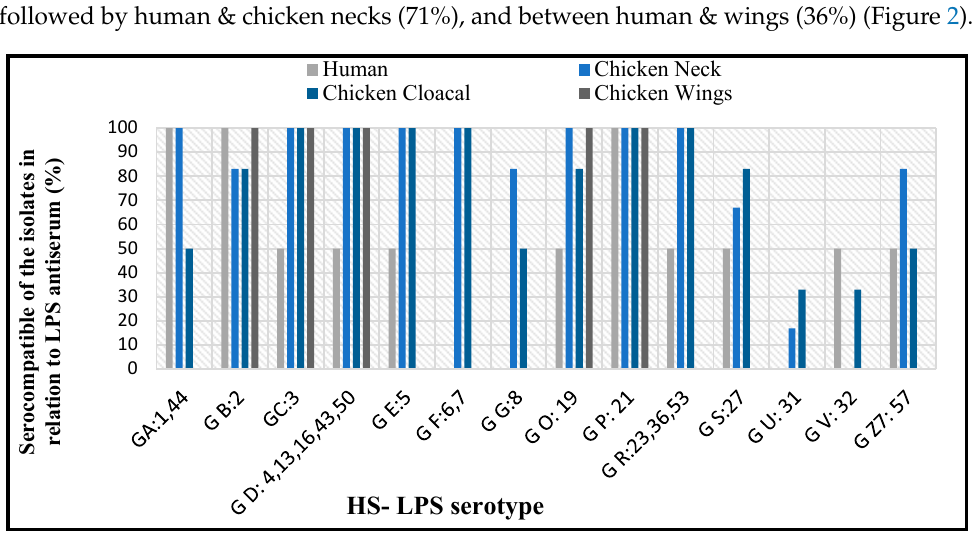
Figure 2. Percentages of serocompatibility in C. jejuni among isolates from human and chickens.